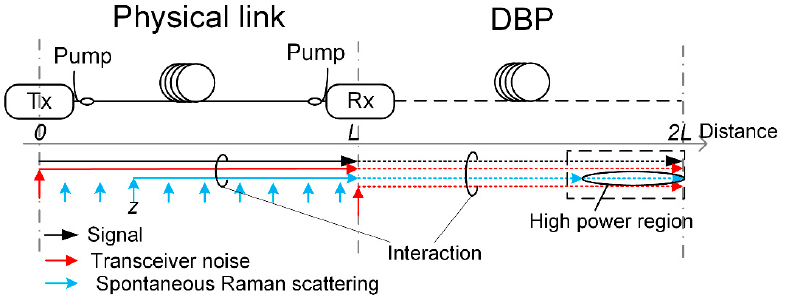
Figure 1. Nonlinear signal-to-noise interaction (NSNI) in a bi-directional Raman system with receiver-side digital back-propagation (DBP).